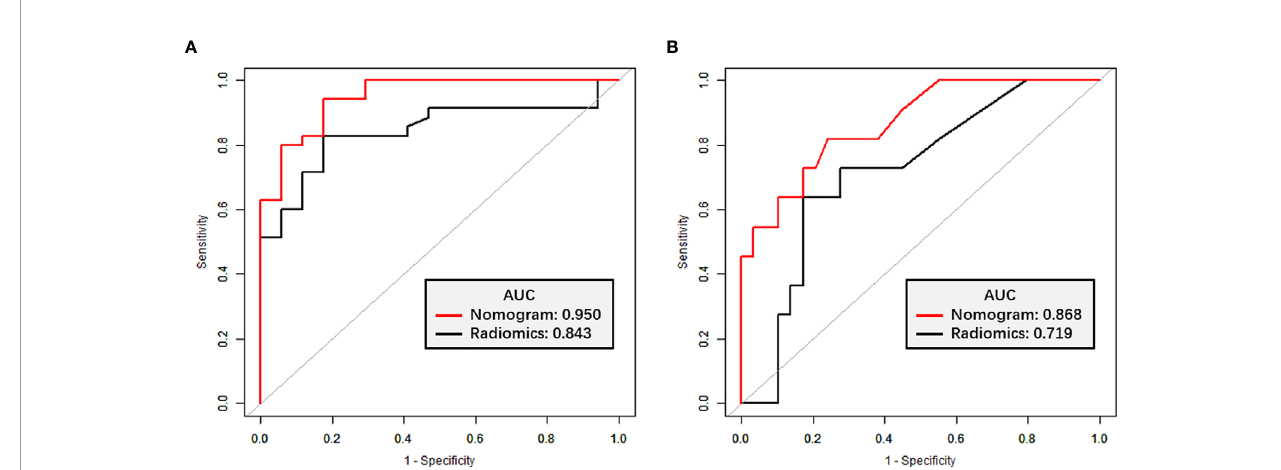
FIGURE 6 | ROC curves for TRG classi fi cation. (A) ROC curves for the radiomics signature and nomogram models in the training set. (B) ROC curves for the radiomics signature and nomogram models in the validation